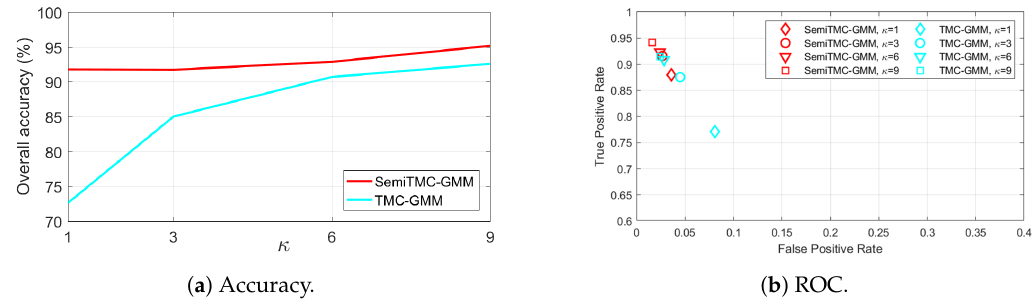
Figure 5. The batch mode recognition performance of the Locomotion of Foot-mounted IMU (LMFIMU) dataset, SemiTMC-GMM, and TMC-GMM models, according to different GMM mixture number κ